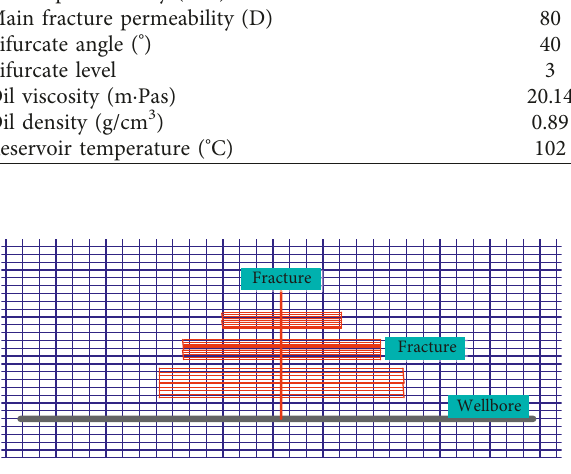
Figure 4: A schematic diagram of fracture geometry in a numerical simulation of Eclipse 2011.